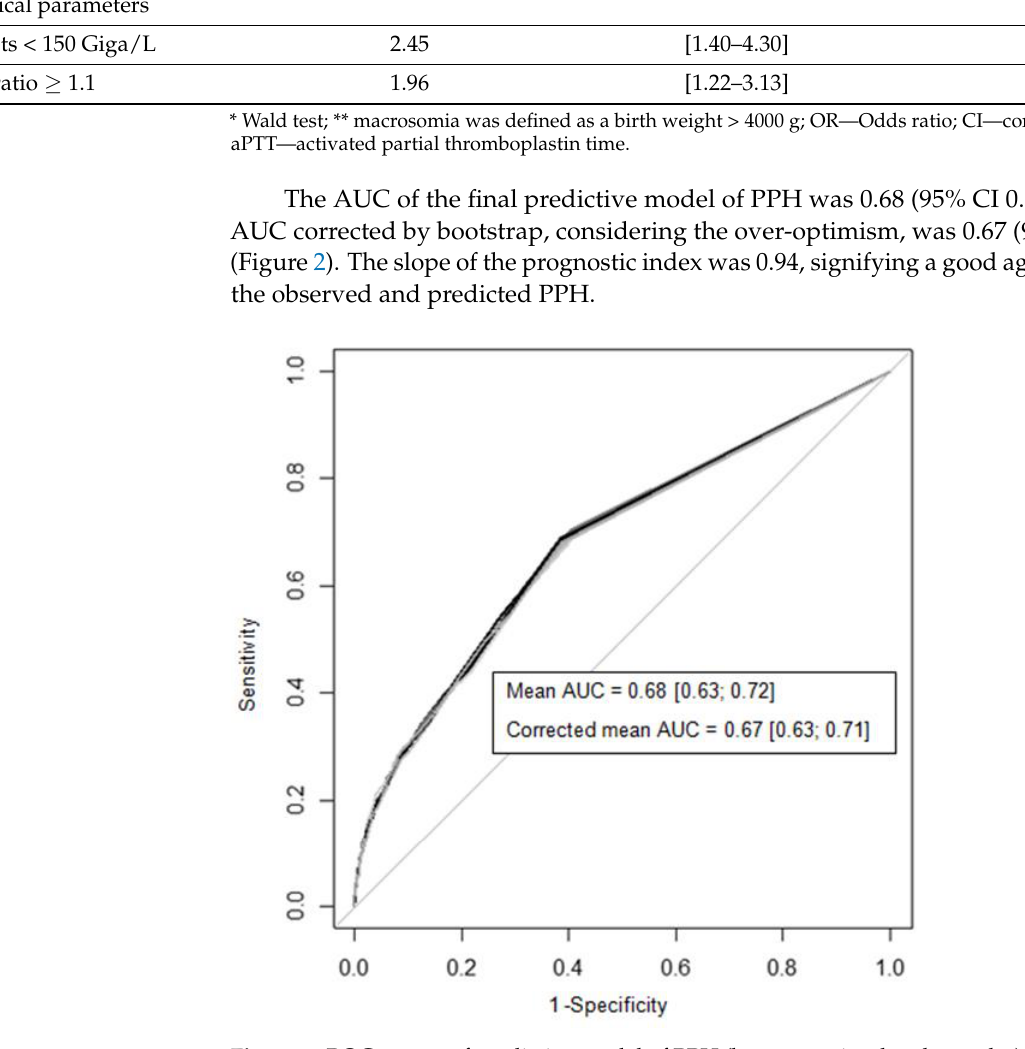
Figure 2. ROC curves of predictive model of PPH (bootstrap simulated samples). AUC—area under the ROC curve.